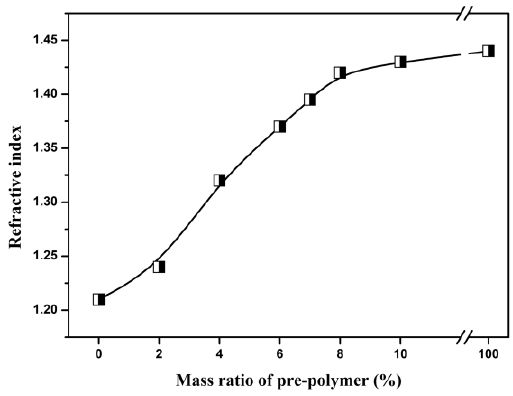
Figure 3. The relationship between the coating reflective index and mass ratio of pre-polymer.